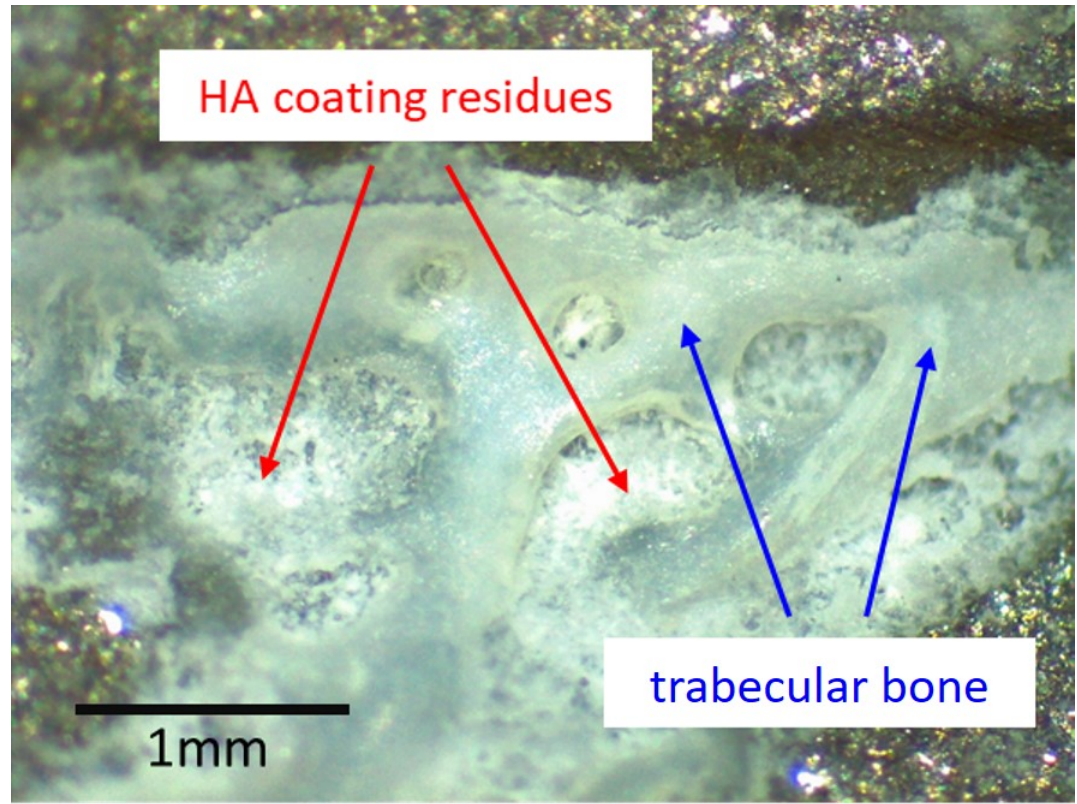
Figure 3. Optical microscopy image of one of the patches of ongrown bone at the surface of the retrieved stem. Light reflexes from the metal surface limit such analysis to areas with limited light